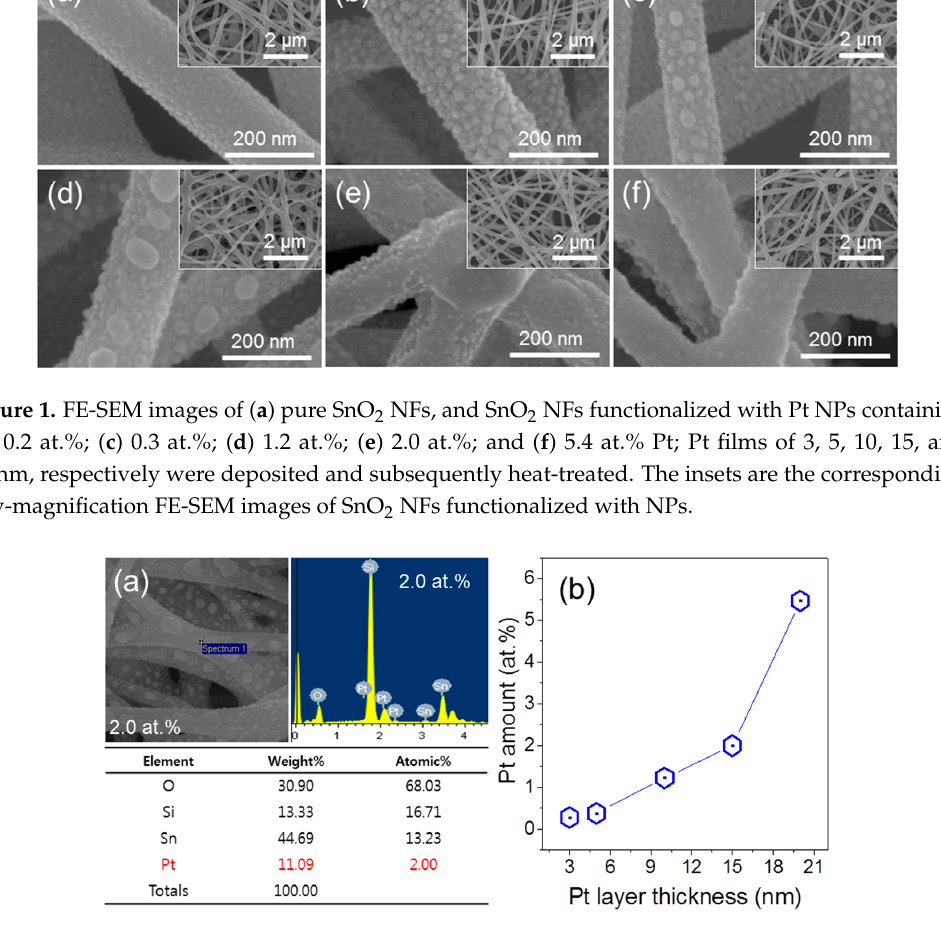
Figure 2. ( a ) Elemental analysis of 2.0 at.% Pt-functionalized SnO 2 NFs using EDS; ( b ) Relationship between Pt amount and Pt layer thickness.